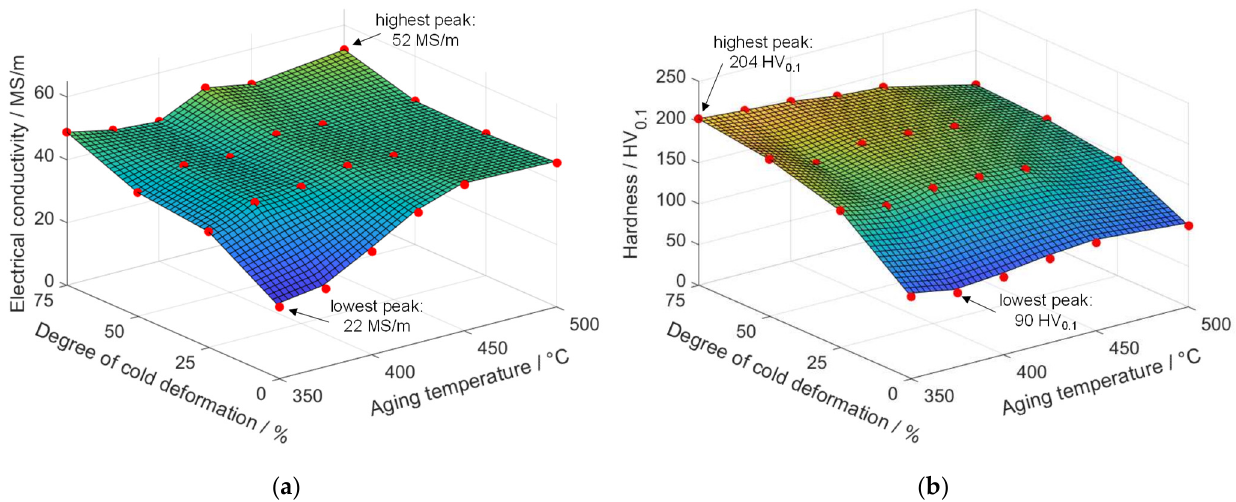
Figure 10. Properties of CuHf0.7 resulting from isothermal aging treatment at 350 °C to 500 °C up to 48 h; ( a ) maximum hardness; ( b ) maximum electrical conductivity. 48 h; ( a ) maximum hardness; ( b ) maximum electrical